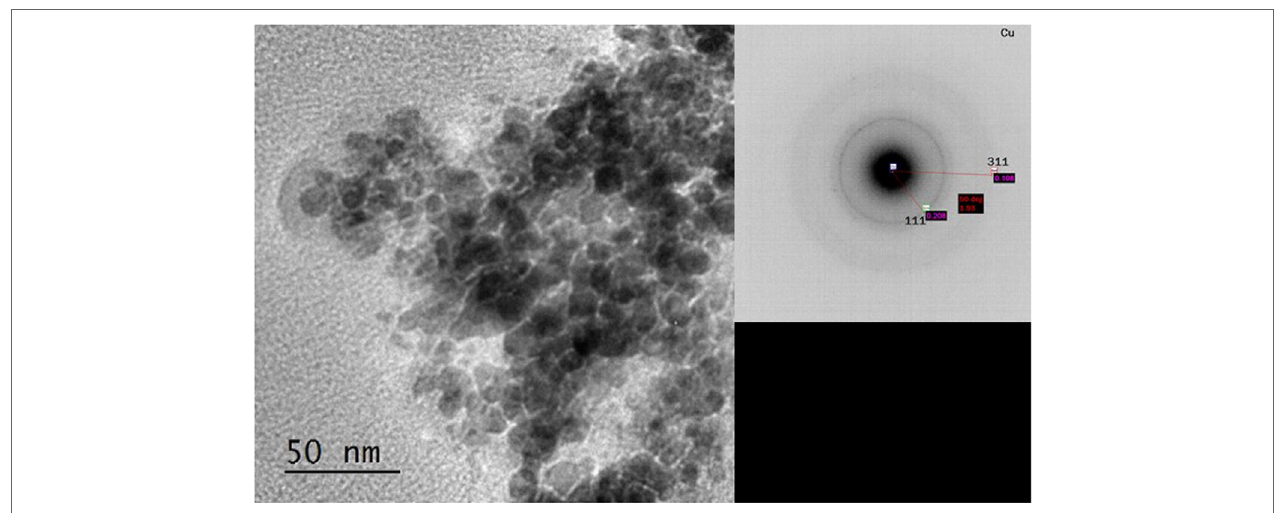
FigUre 3 | TEM image and electron diffraction of Cu from step F with 10 ± 2 nm particles sizes and [111] and [311] Cu 0